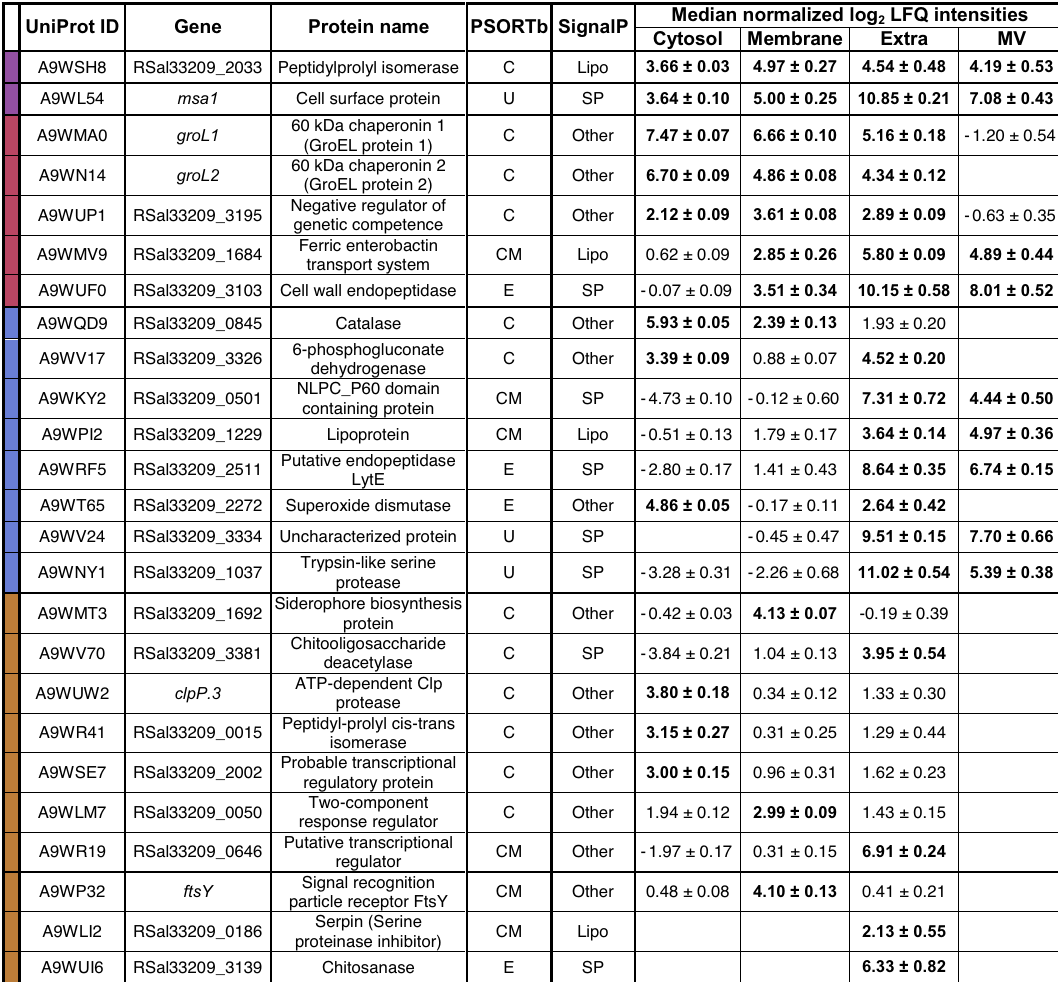
Table 1. 25 highly abundant proteins that are involved in virulence of R. salmoninarum and their subcellular localization Proteins are with their predicted PSORTb localizations (U = unknown; C = cytoplasmic; CM = cytoplasmic membrane; E = extracellular), their predicted SignalP signal peptides (SP = secretory signal peptides transported by the Sec translocon and cleaved by Signal Peptidase I; Lipo = lipoprotein signal peptides transported by the Sec translocon and cleaved by Signal Peptidase II; OTHER = no detectable signal peptide) and the mean log2 transformed median normalized LFQ intensities in the four enriched subcellular fractions with their standard deviation between replicates (n = 4; Cyt = cytosol, Mem = membrane, Extra = extracellular, MV = membrane vesicles). Proteins are grouped and colored according to their abundance (higher than a log2 transformed median normalized LFQ intensity of 2, indicated in bold) in —4 of 4 subcellular fractions; —3 of 4 subcellular fractions; —2 of 4 subcellular fractions; ; —1 of 4 subcellular fractions. Within the groups, the listed proteins are sorted according to their theoretical subcellular